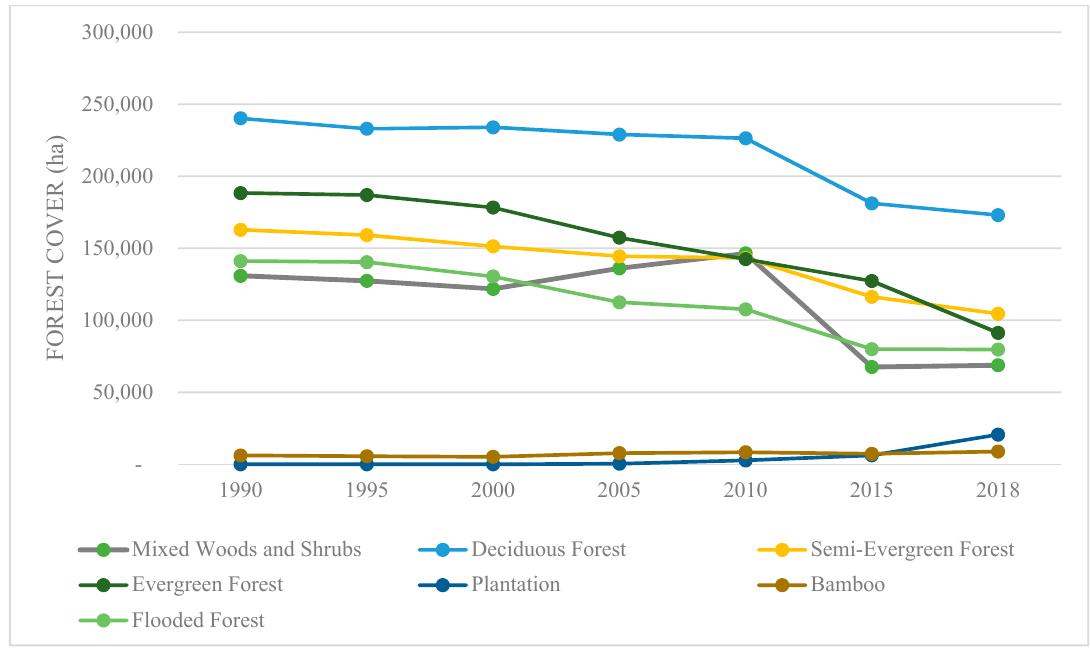
Figure 6. Trend of forest land cover change in Siem Reap province from 1990 to 2018.